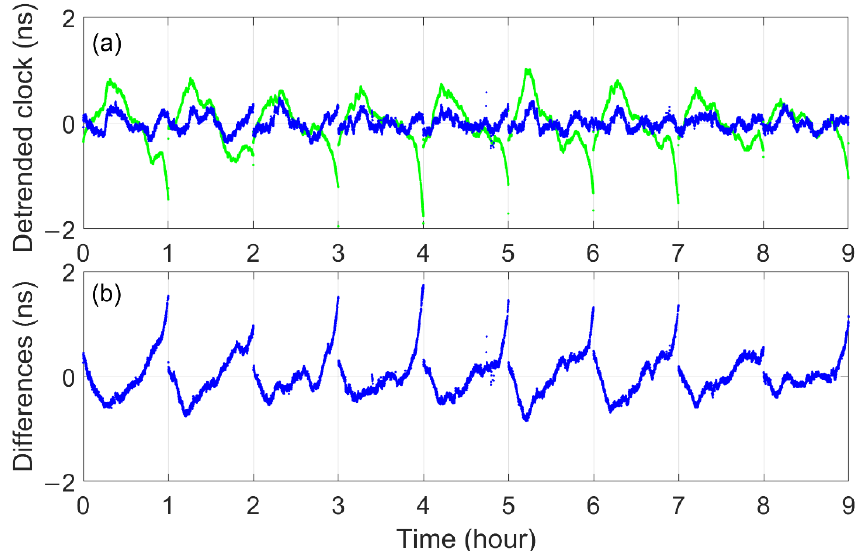
Figure 11. Satellite clock offset differences between the Ka-band inter-satellite estimated clock offsets and GBM products for 9 days. All of them are deducted the same trends per day (since 19 May 2022). Wherein, ( a ) are their detrended clock offsets, ( b ) are their differences. Taking the high-accuracy inter-satellite clock offsets and L-band two-way clock off- sets of GEOs as inputs, the clock offsets of all satellites can be further traced to the BDT so as to estimate the final clock offsets, whose accuracy should be better than the clock offsets calculated by two-way superimposition strategy, which can be shown in Figure 9. The top panel of Figure 9 describes the GEO clock offsets. The middle panel of Figure 9 describes the typical IGSO clock offsets, and the bottom panel of Figure 12 describes the typical MEO clock offsets curves are the two-way estimated clock offsets. Wherein the red curves are the clock offsets directly calculated by L-band two-way clock offsets or superimposed by L-band two-way clock offsets and C-band inter-satellite clock offsets.